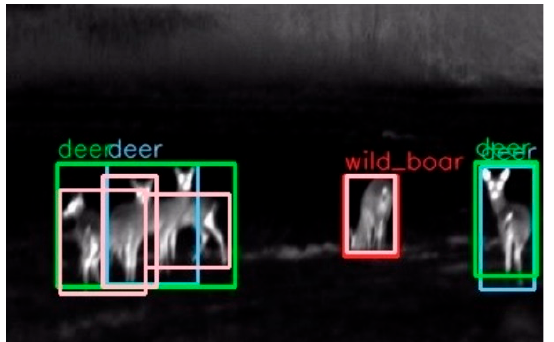
Figure 7. Example of poor detection result for HOG/SVM—the animals’ silhouettes are overlaying on each other.